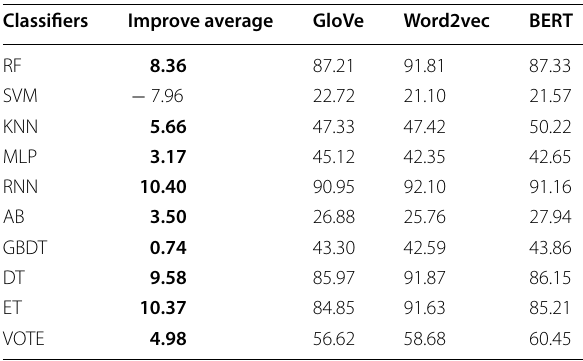
Table 16 Accuracy result